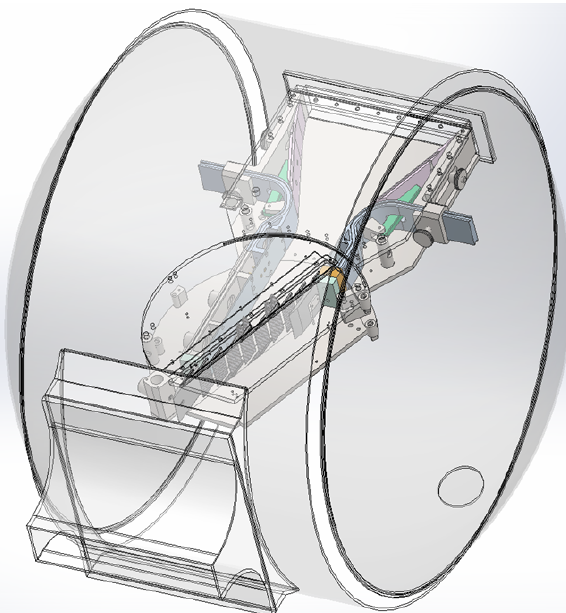
Figure 6. Original model of Experimental test